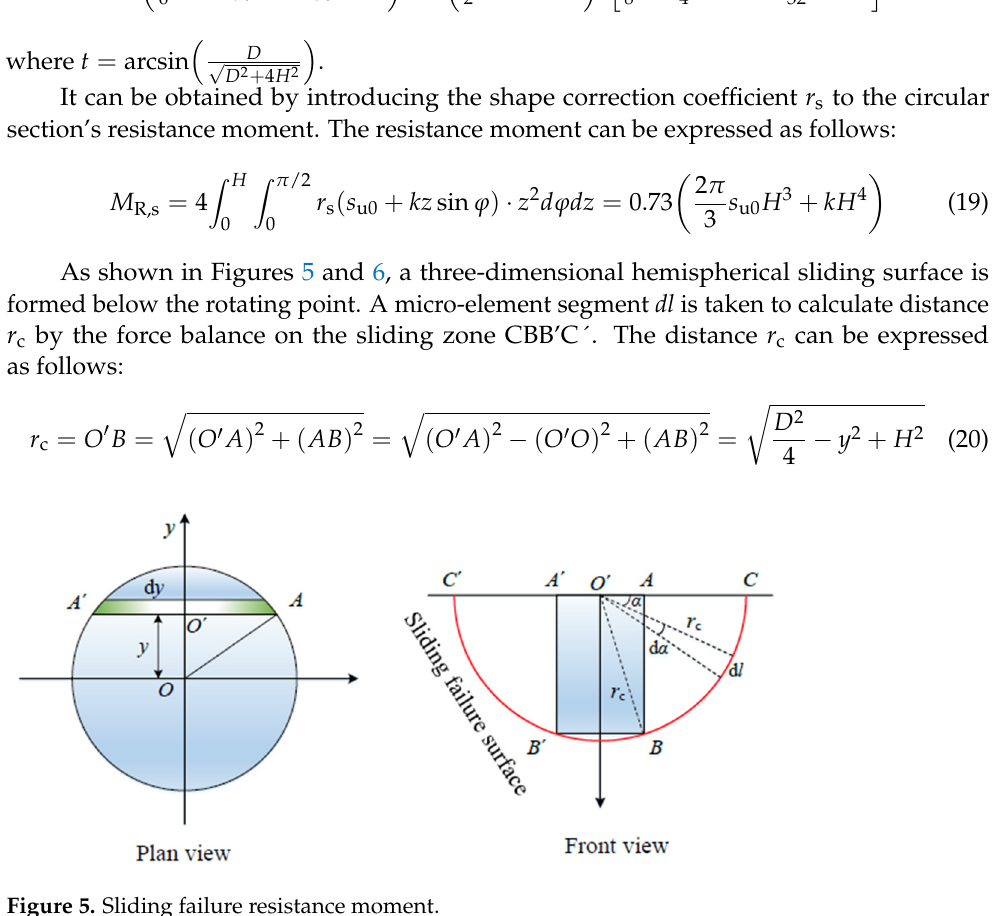
Figure 5. Sliding failure resistance moment.